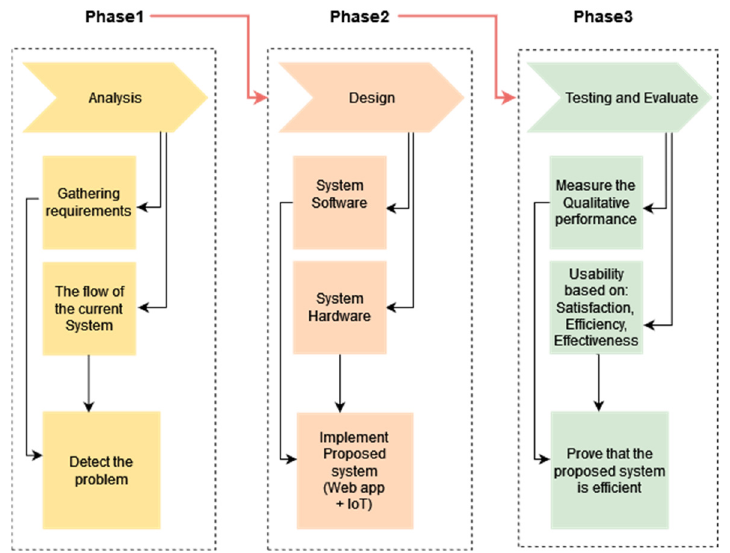
Figure 2. The methodology of the study.